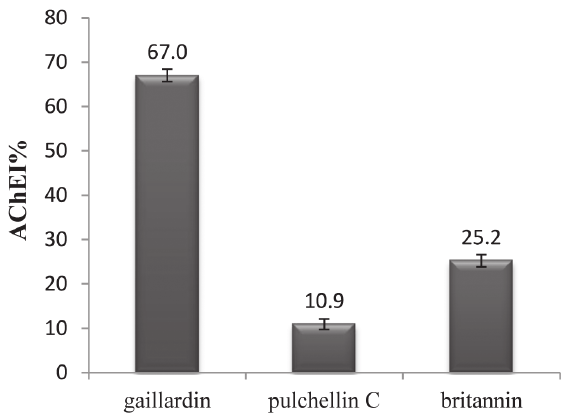
Figure 3 - AChEI activity of gaillardin, pulchellin C and britannin in concentration of 300